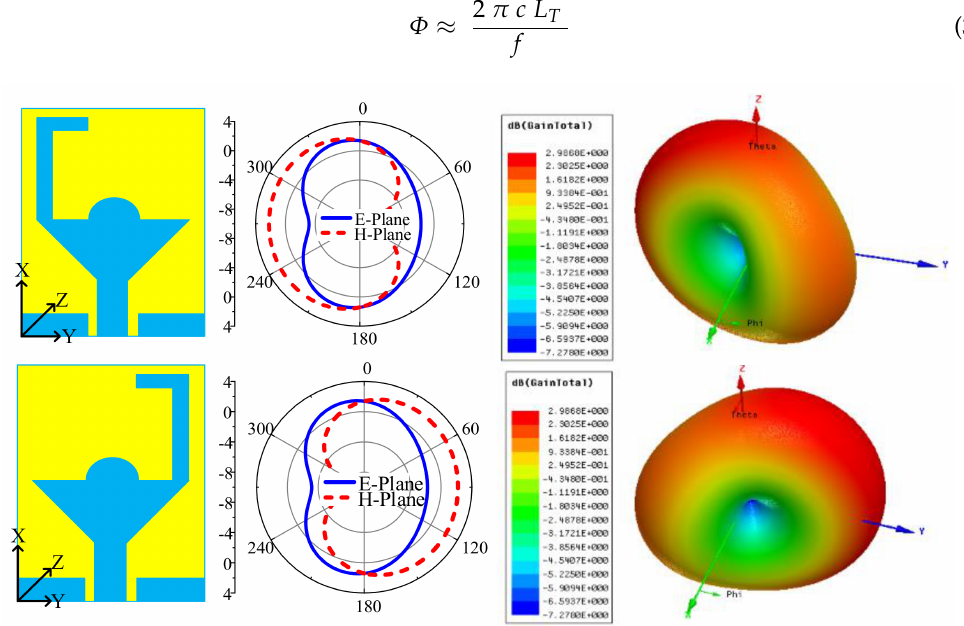
Figure 3. Effect of stub loading on the radiation patterns of the